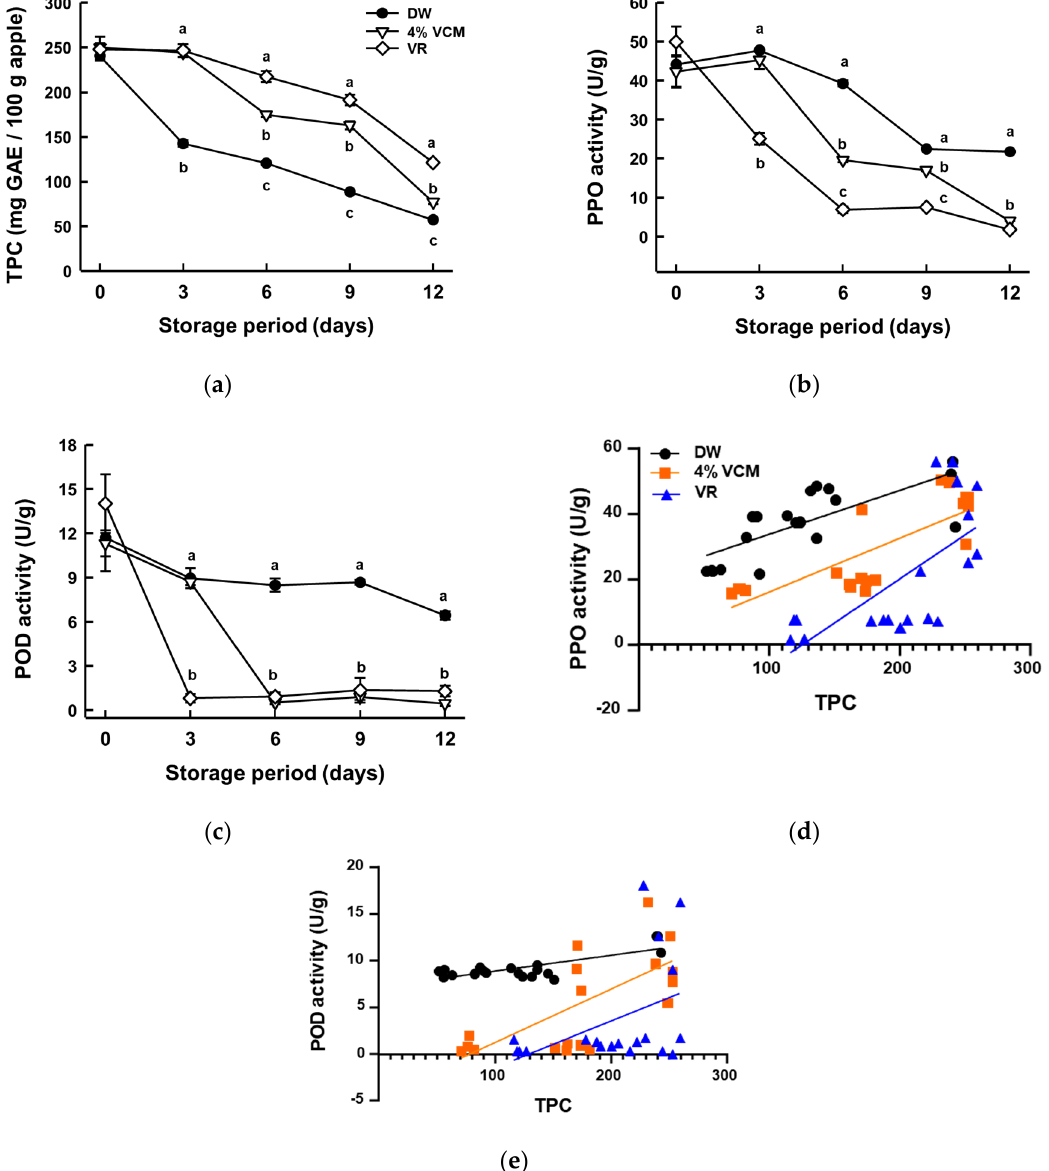
Figure 4. Analysis of TPC and phenolic oxidase activity in freshly cut apples. Differences in TPC, PPO, and POD activity changes in freshly cut apples soaked on days 0, 3, 6, 9, and 12. ( a ) TPC, ( b ) PPO activity, and ( c ) POD activity. Statistical significance was determined by one-way ANOVA (mean ± SE, n = 3). Pearson’s correlation coefficient TPC and PPO ( d ), TPC and POD ( e ).